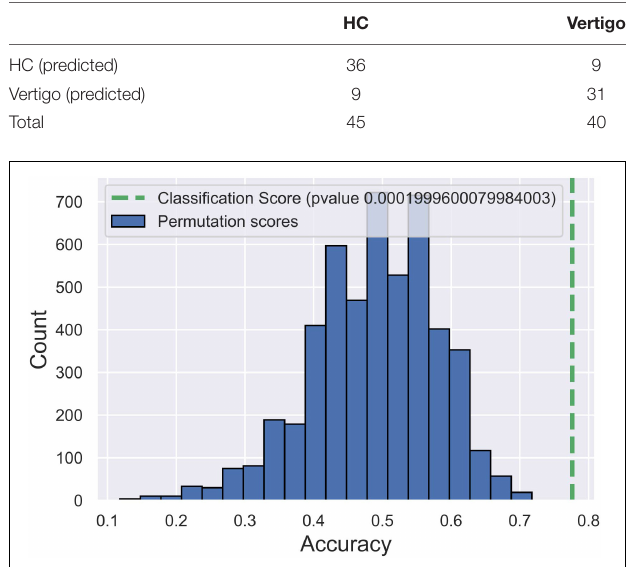
Frontiers in Aging Neuroscience |